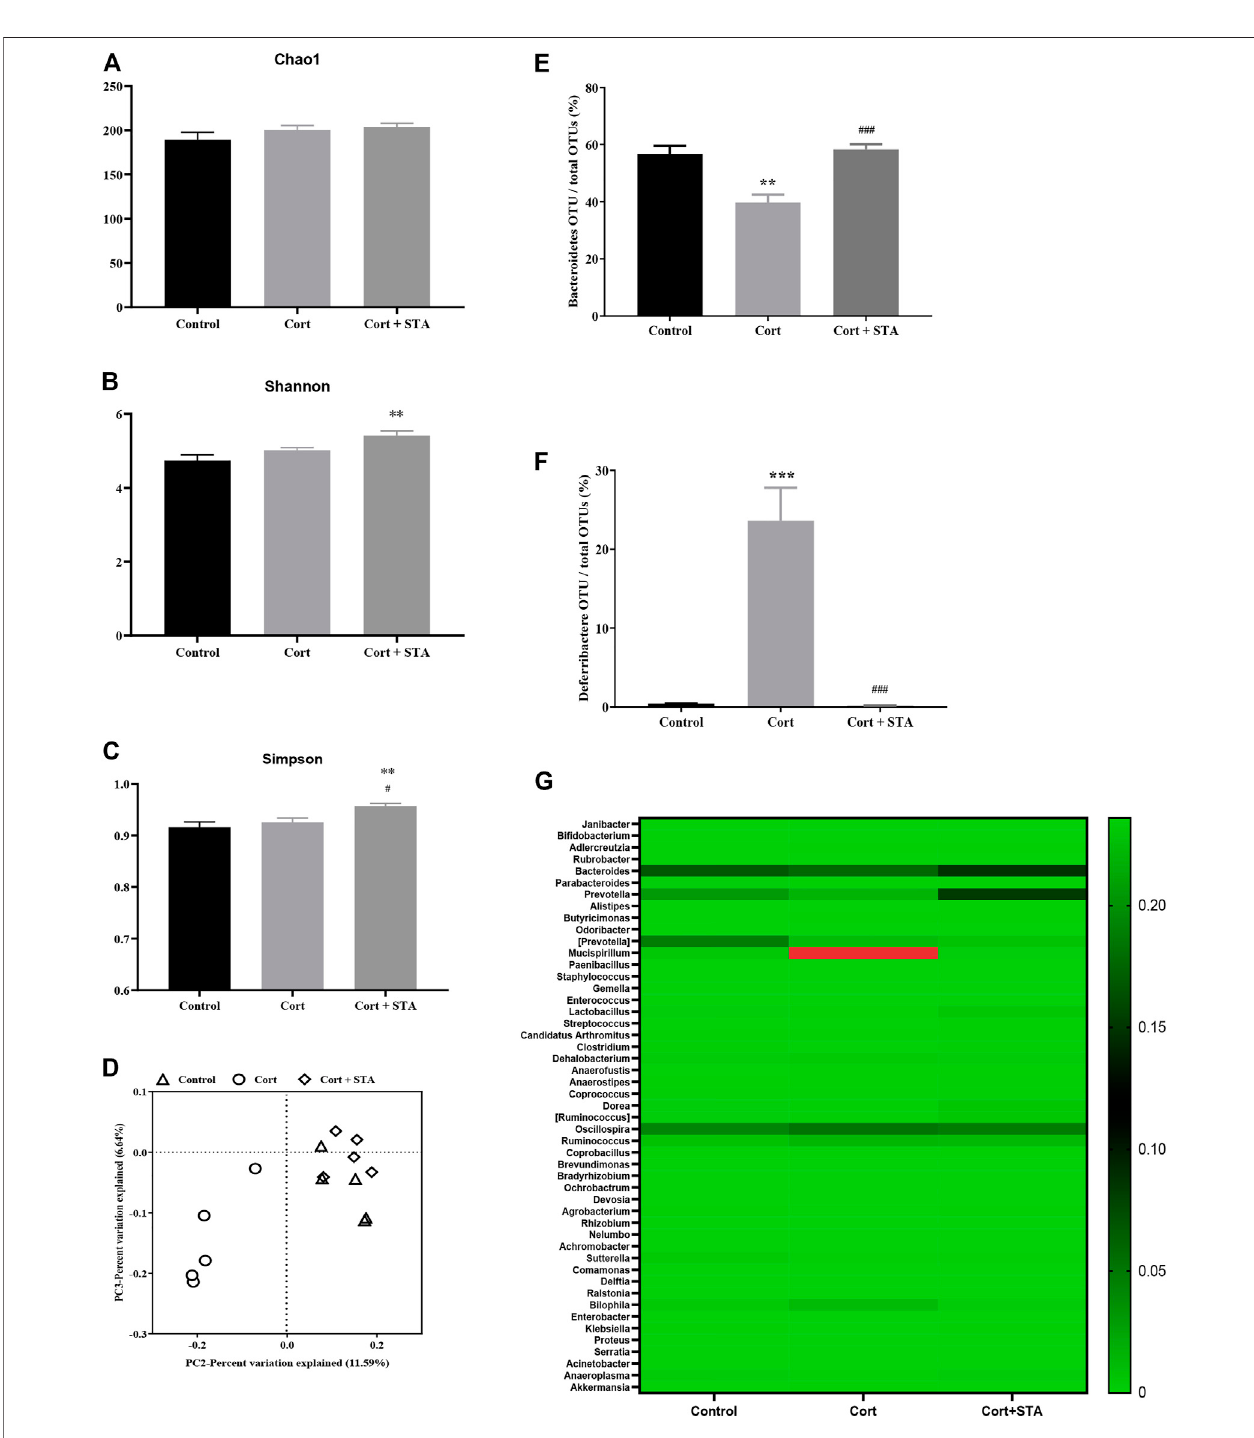
FIGURE 2 | Effects of stachyose (STA) on gut fl ora. (A – C) Evaluation of the alpha diversity of gut fl ora. (D) PCA plot based on subsampled unweighted Unifrac distances. (E) Relative abundance of Bacteroidetes operational taxonomic unit (OTU) at the phylum level. (F) Relative abundance of Deferribacteres OTU at the phylum level. (G) Heatmap of the 49 most abundant OTUs at the genus level. Data are shown as the mean ± SEM, n = 5. * p < 0.05, ** p < 0.01, *** p < 0.001 compared to the Control group; # p < 0.05, ### p < 0.001 compared to the Cort group. hippocampal D-serine and L-serine in stachyose and corticosterone-treated mice ( Figure 3A , L-serine, Cort vs. Control: p = 0.4774, STA vs. Control: p = 0.2651, Cort + STA